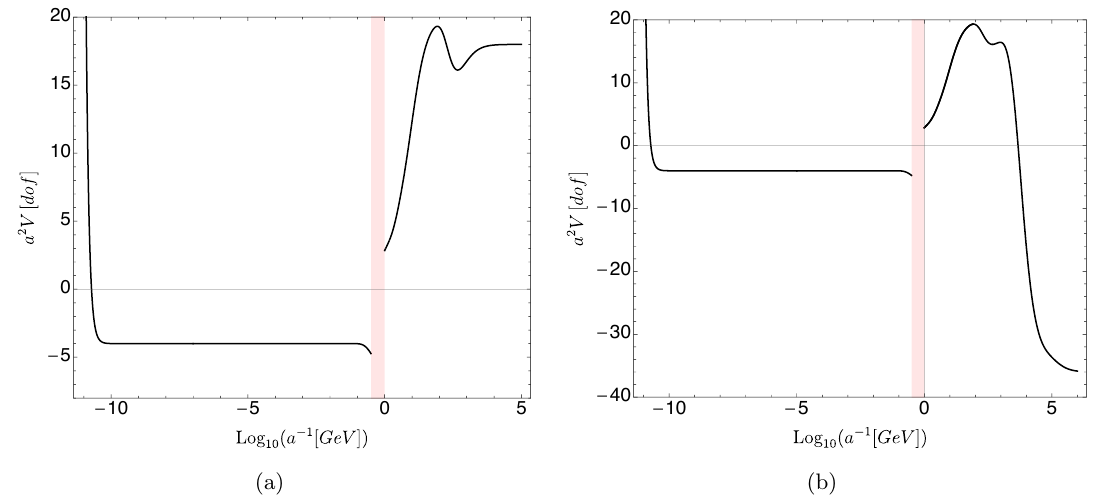
Figure 5 . (a) E(cid:11)ective potential of the Standard Model compacti(cid:12)ed in T 2 =Z 4 embedded into a discrete subgroup of the SU(3) colour Cartan subalgebra. All particles have periodic boundary conditions. As usual, the Higgs is (cid:12)xed at its minimum. There is no runaway solution, so the minimum which appears around the QCD transition is of type D. The SM as it is appears to be inconsistent with Quantum Gravity. (b) The same plot but for the MSSM. The addition of extra bosonic degrees of freedom creates a runaway behaviour in the potential which could make the minima unstable. The MSSM would then appear to be consistent with the no stable AdS